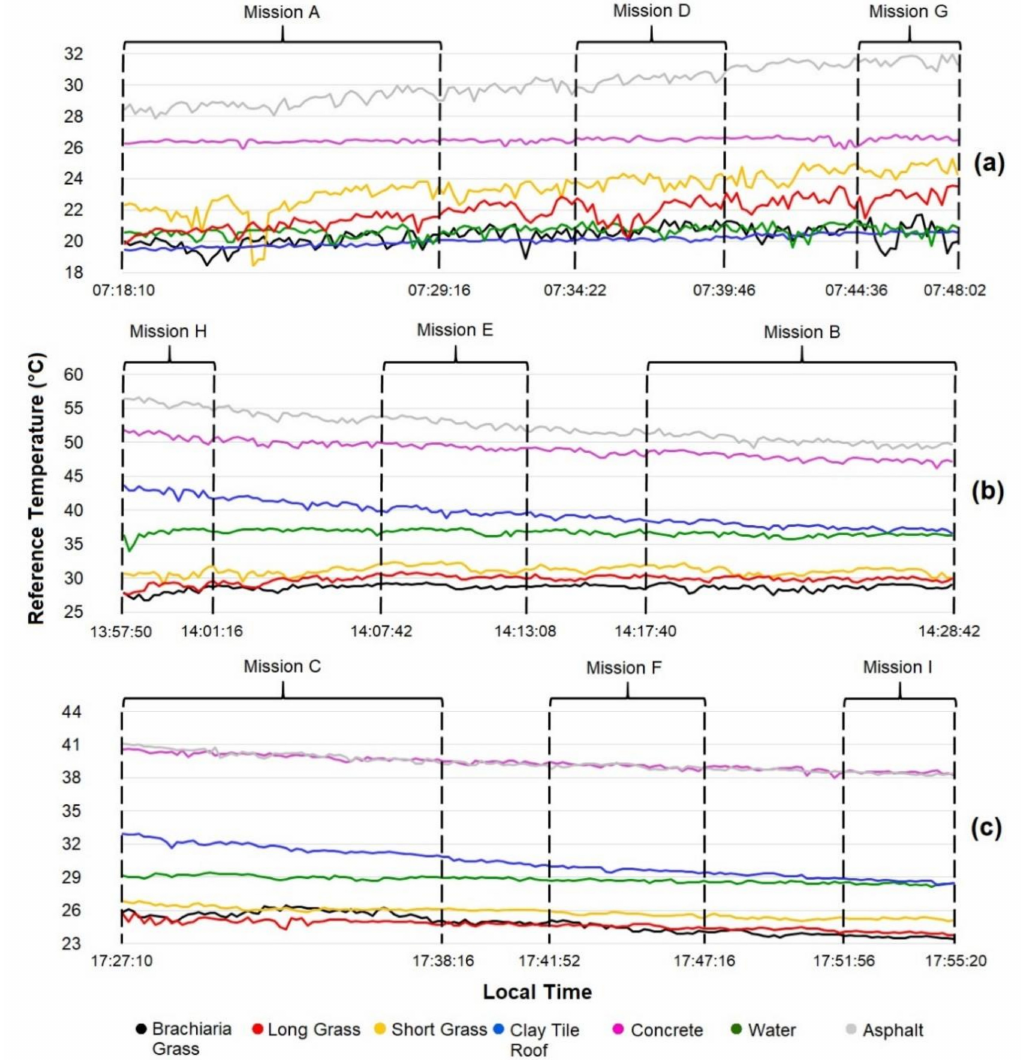
Figure 5. Ground reference temperature from validation targets across all missions. Missions conducted in the early morning ( a ), close to solar noon ( b ), and at the end of the afternoon ( c